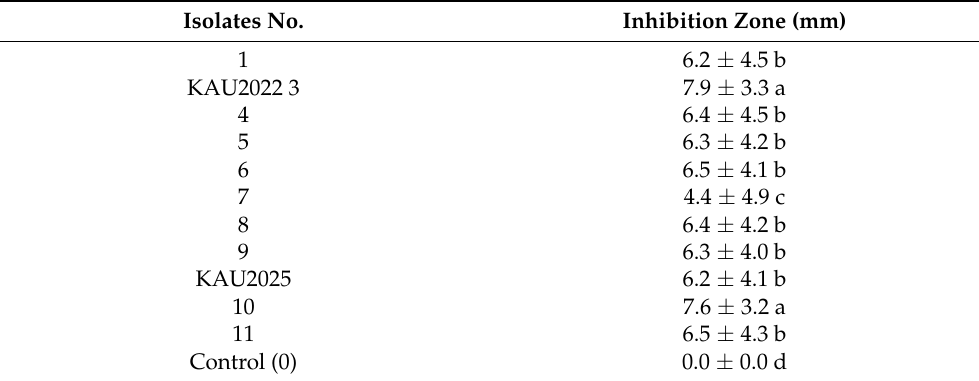
Table 3. In vitro screening of different bacterial isolates against highly virulent isolate of Fusarium oxysporum .